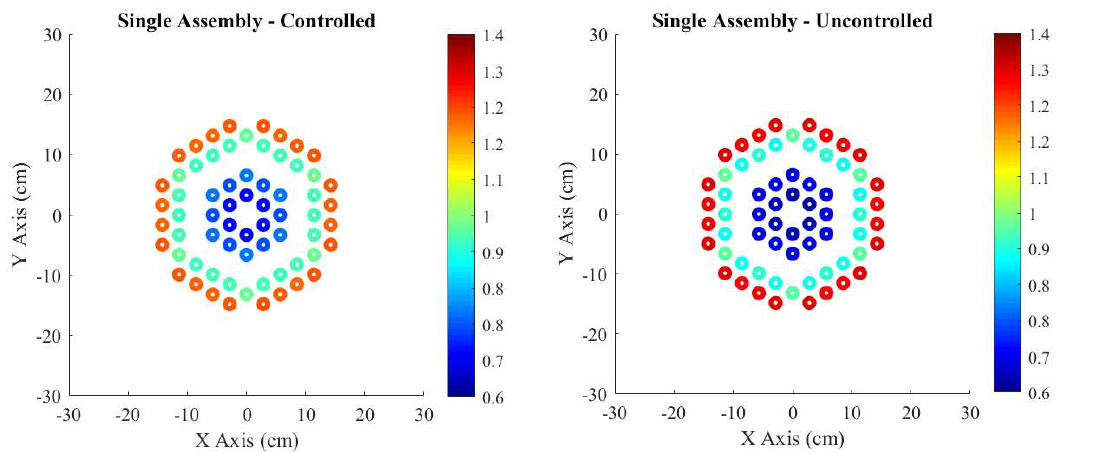
Figure 4. Relative Pin Fission Density Distribution in Single Assembly